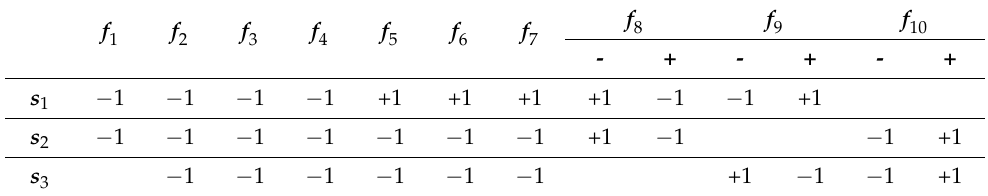
Table 4. Physically possible three-valued fault